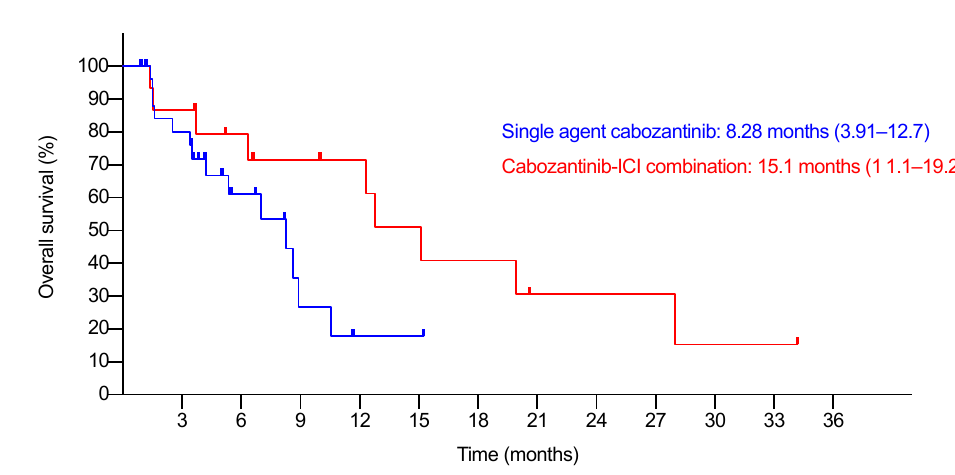
Figure 1. Kaplan–Meier analysis of OS of single-agent and cabozantinib–ICI combination patients.